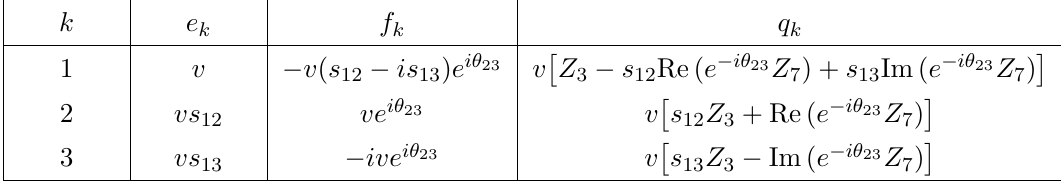
Table 8 . Values of e k , f k and q k de(cid:12)ned in eqs. (D.21) and (D.24) in the approximate alignment limit. Deviations from the alignment limit are treated to linear order in s 12 and s 13 [cf. eqs. (D.41) and